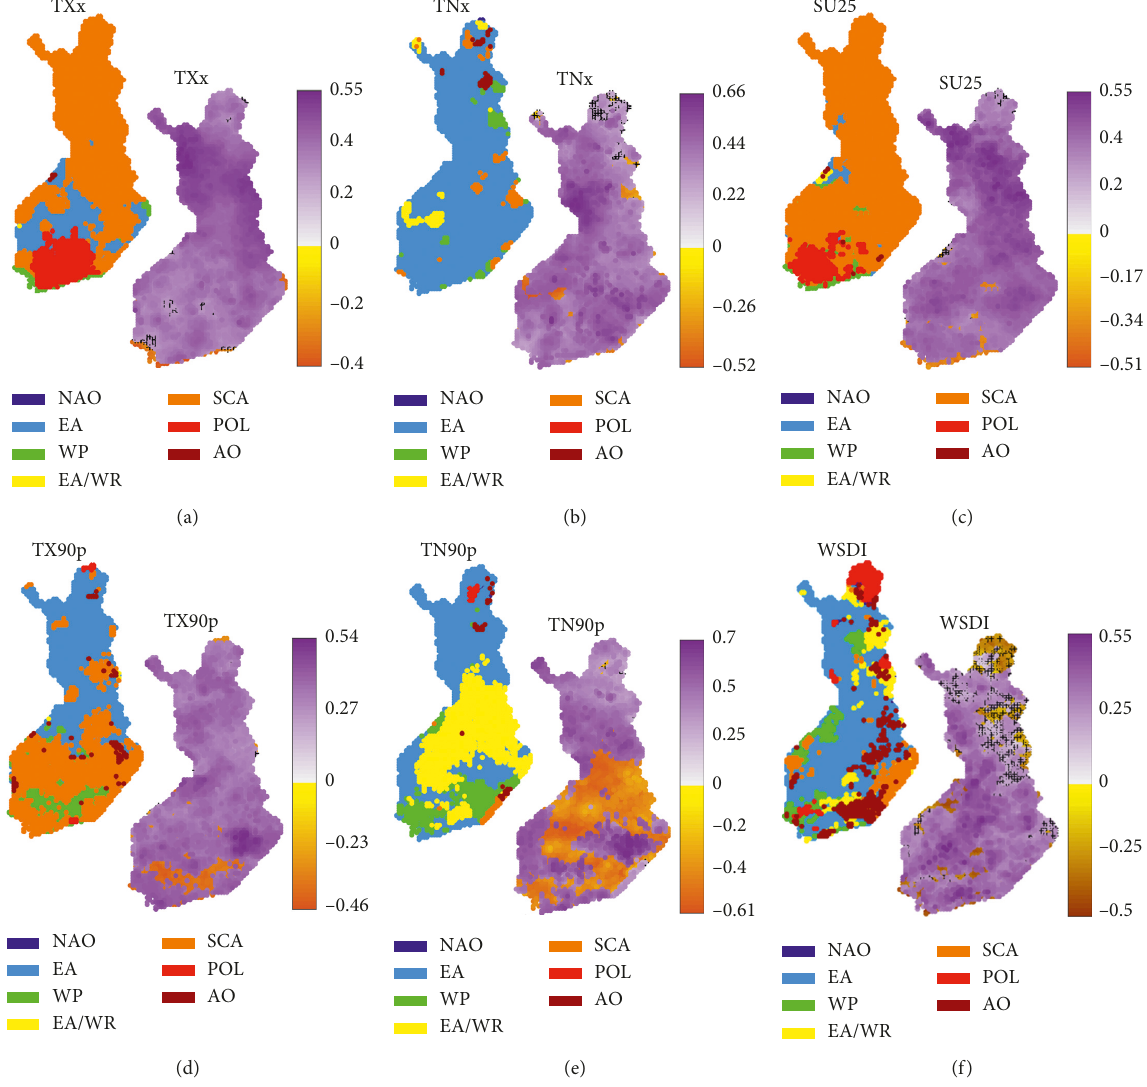
Figure 9: Spatial distribution maps of most influential NHTP (left) and its corresponding Spearman rank correlation (right) for warm extreme temperature indices including (a) TXx, (b) TNx, (c) SU25, (d) TX90p, (e) TN90p, and (f) WSDI in Finland during 1961–2011. The stippling indicates areas where the correlations are statistically insignificant ( p >